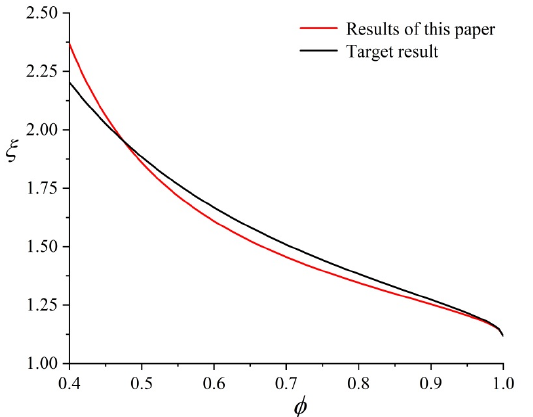
Figure 4. Comparison of the proposed model of tortuosity with previously published [23] results— upper limit arrangement.